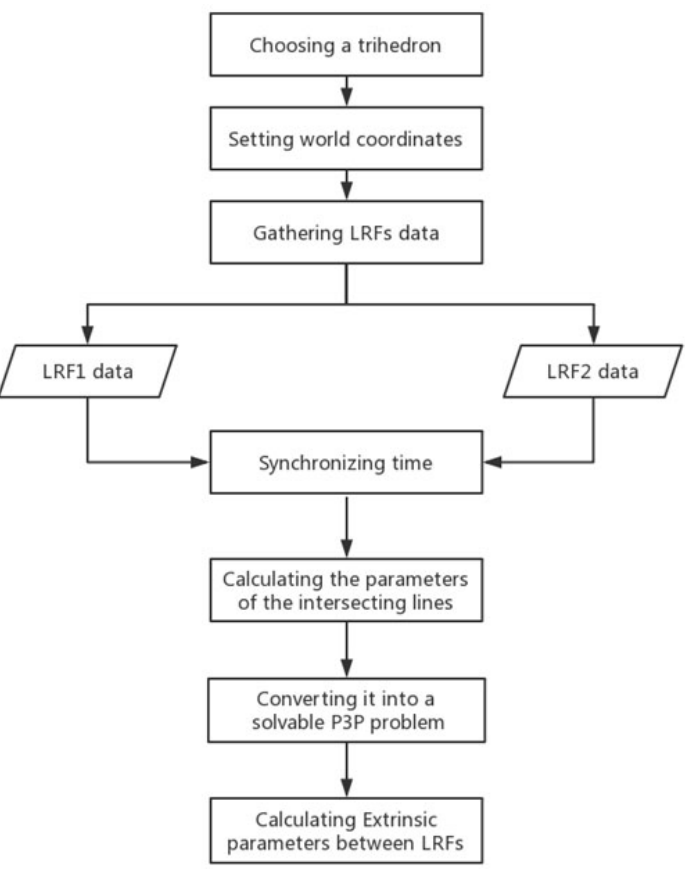
Figure 4. The process of